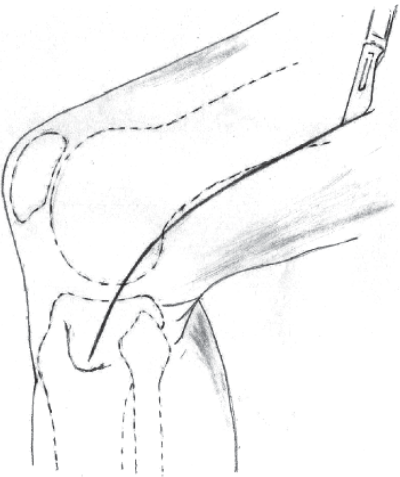
Figure 1 - Schematic drawing showing skin incision in the lateral face of the knee and the distal third of the